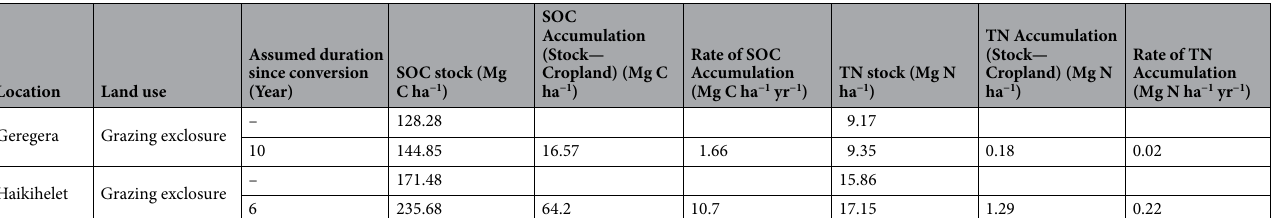
Table 3. Magnitude and rate of soil organic carbon (SOC) and total nitrogen (TN) stocks accumulation in exclosures at 0–90 cm depth in Geregera and Haikihelet [grazing land as baseline].